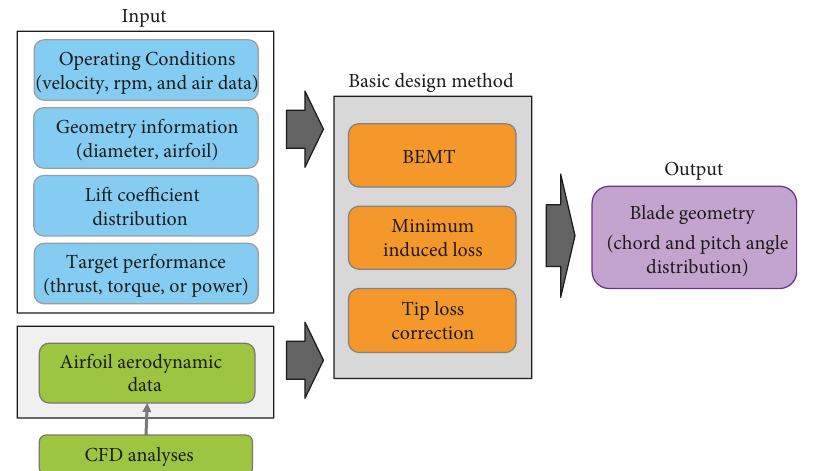
Figure 1: Schematic of the basic propeller design code.